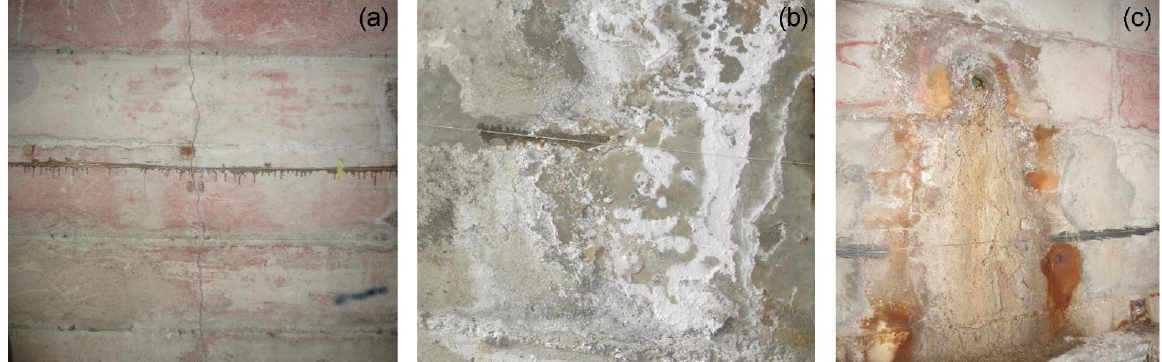
Figure 10. Crack on the tunnel wall crossed by the glued fiber ( a ); parget swelling and salt precipitate accumulation ( b ); salt precipitate accumulation ( c ).